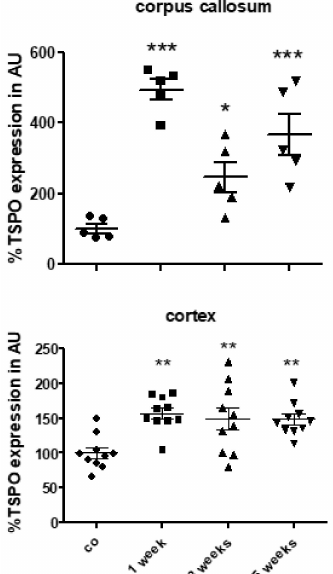
Figure 4. Expression levels of Tspo mRNA during the course of cuprizone-induced demyelination. Tspo mRNA levels in the control animals ( n = 5) and the animals intoxicated with cuprizone for one ( n = 5), three ( n = 5) or five ( n = 5) weeks. Differences between the groups were statistically tested using one-way ANOVA with the obtained p-values corrected for multiple testing using the Dunnett’s post-hoc test; * p ≤ 0.05, ** p ≤ 0.05, *** p ≤